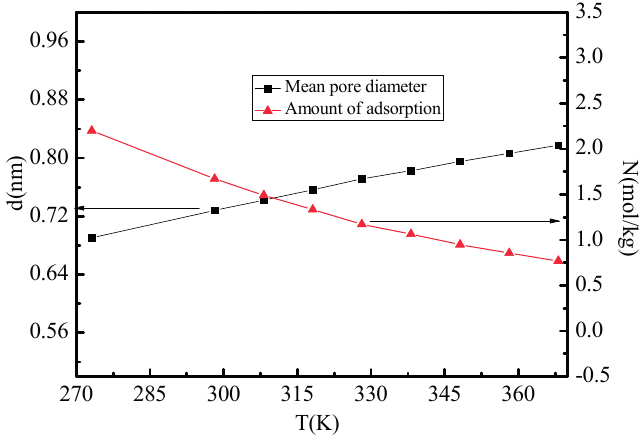
Figure 6. Varying mean pore diameter and amount of H 2 adsorption at